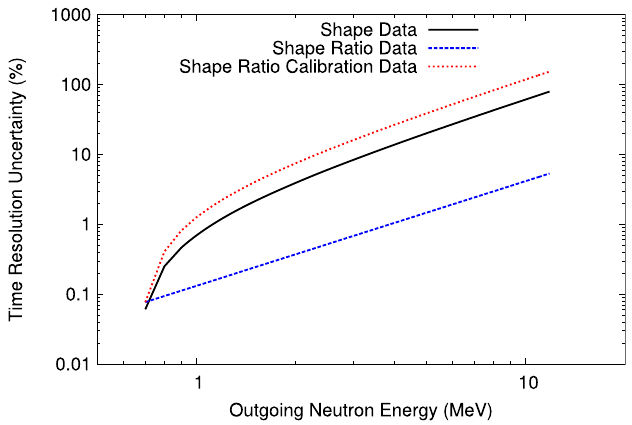
Fig. 1. The total time resolution uncertainty relative to the PFNS is compared for shape, shape ratio and shape ratio calibration data for a time resolution of 1 ns, a TOF length of 1 m for all measurements and Maxwellian temperatures of 1.33 and 1.42 MeV for the investigated and the monitor isotope,